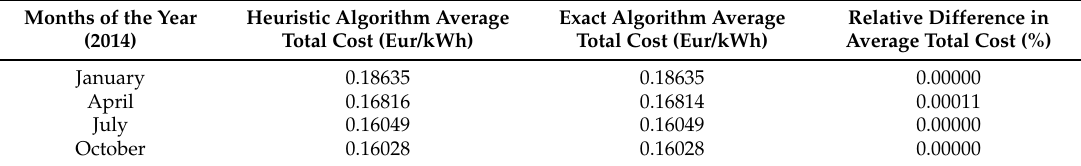
Table 3. Simulation Result of TOUP Model across representative seasons of the year.